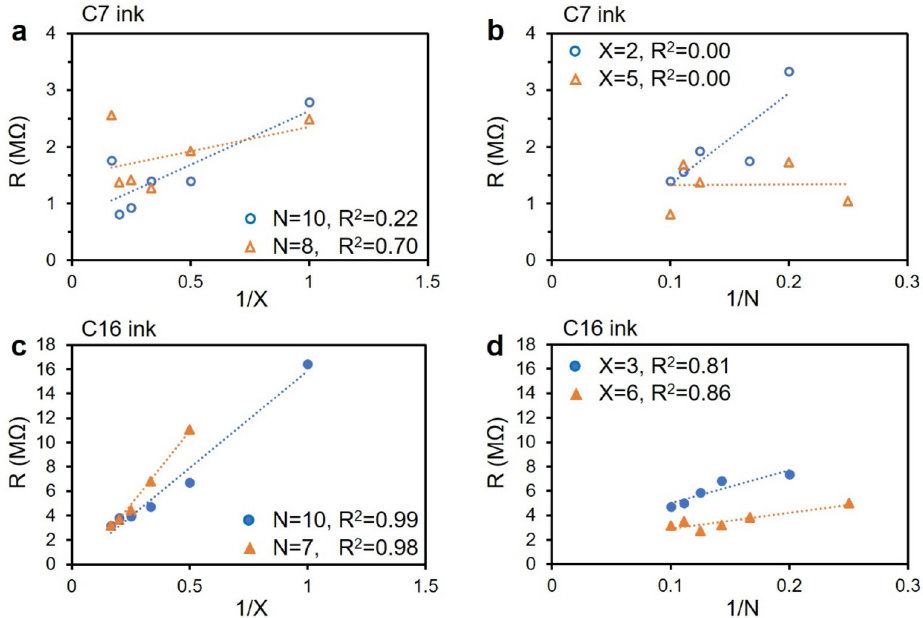
Figure 6. ( a ) Resistance of the C7 ink vs. 1/X (pt −1 ) when N (print −1 ) is constant; ( b ) resistance of the C7 ink vs. 1/N when X is constant; ( c ) resistance of the C16 ink vs. 1/X when N is constant; ( d ) resistance of the C16 ink vs. 1/N when X is